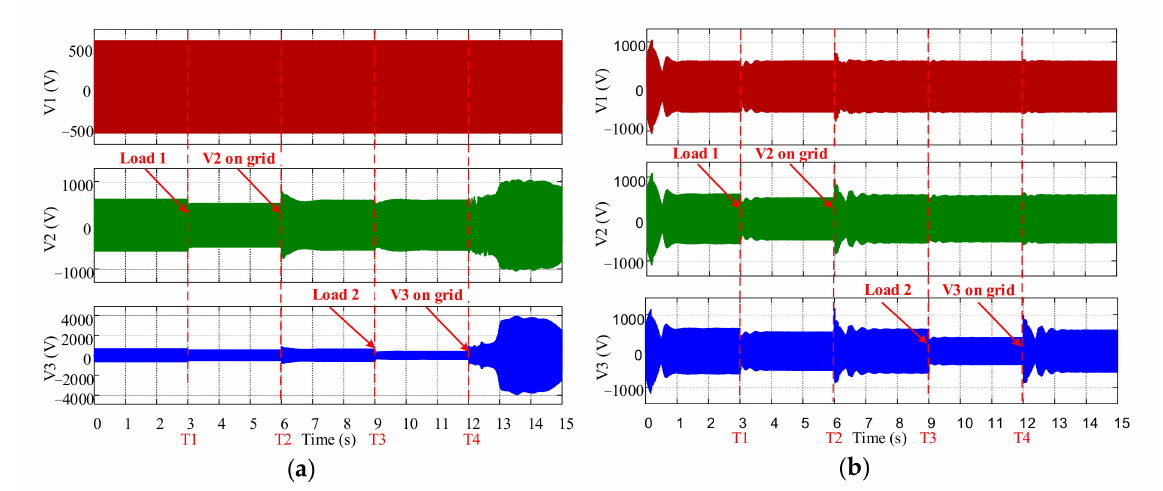
Figure 6. Three substation output voltages of different control strategies under on-load conditions: ( a ) the traditional control strategy; ( b ) the proposed